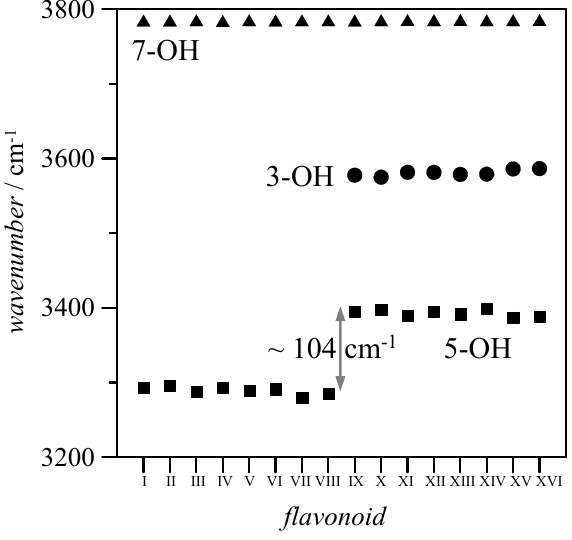
Figure 6. Frequencies of stretching vibrations of hydroxyl groups in 3, 5 and 7 positions (atom numbering as in Figure 1) for the studied flavonoids, calculated in gas phase at B3LYP ⁄⁄ 6-311++G** theoretical level. Reported values show calculated unscaled